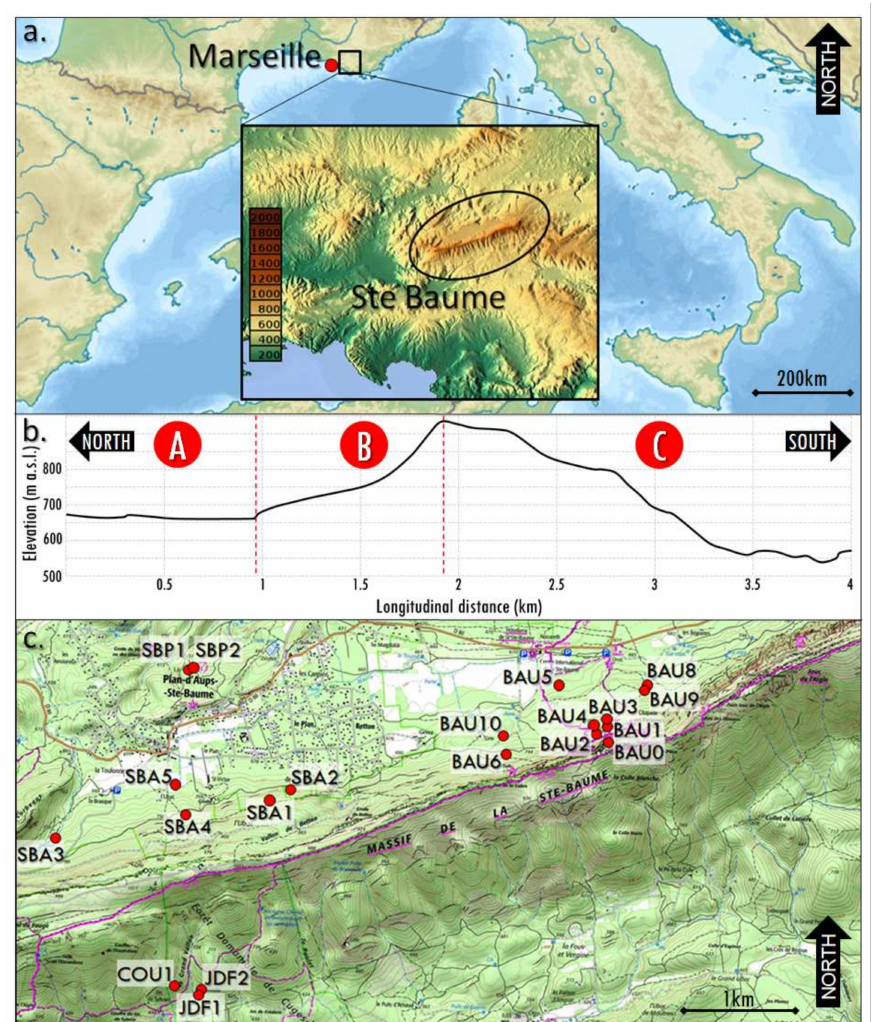
Figure 1. Presentation of the study area: ( a ) location of the Sainte-Baume forest area; ( b ) topographical profile of the Sainte-Baume Massif on the north–south axis passing through the so-called “hotellerie”, the Saint-Pilon Pass and the Vallon de Tr é buquet. The red borders mark the three ecological units in the study area (A: northern plateau; B: Sainte-Baume forest; and C: southern exposure); ( c ) location of the sampled soil profile in the study area (red dots) (used maps under GNU General Public